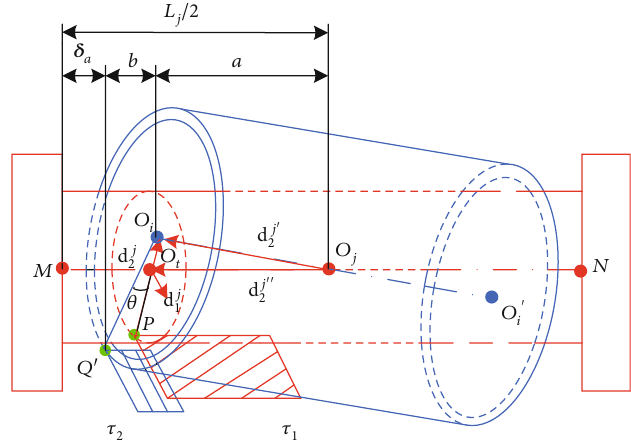
Figure 5: Mathematical model of axial distance of revolute joint with 3D